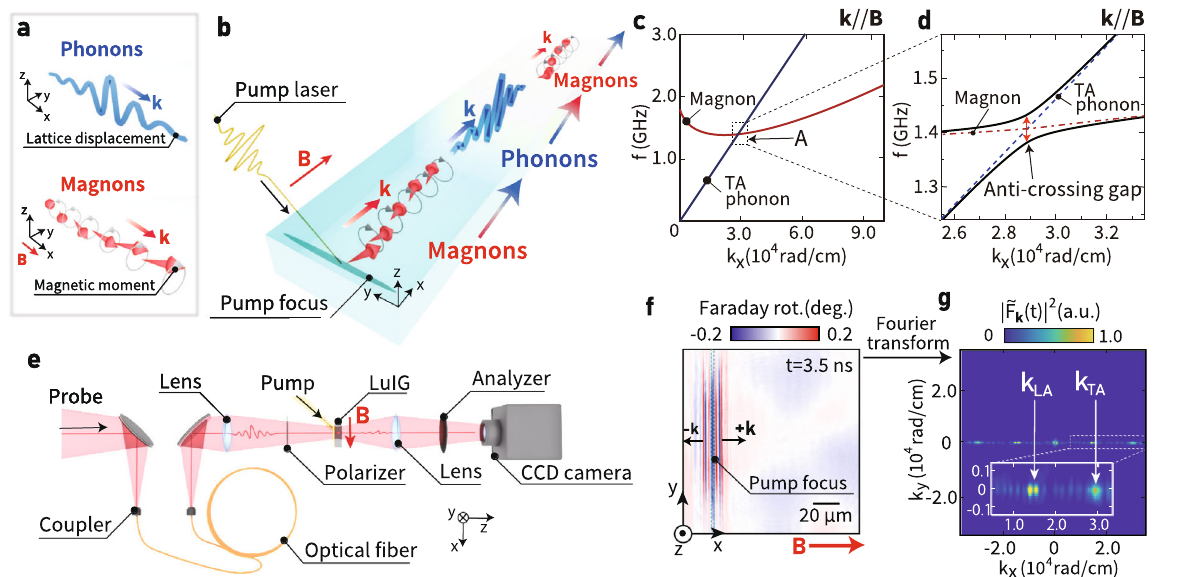
Fig. 1 Concept of coherent oscillation between phonons and magnons, and time-resolved magneto-optical microscopy. a A schematic illustration of phonons and magnons, b A schematic illustration of coherent oscillation between phonons and magnons. c The dispersion curves of phonon and magnon in lutetium iron garnet (LuIG). d A magni fi ed view around A in Fig. 1c. The black curves represent the dispersion relation of hybridized magnon-phonon polaron, while the red and blue dashed curves represents dispersion relation of pure magnons and transverse acoustic phonons, respectively. e Optical setup for the time-resolved magneto-optical microscopy with the extended delay time. The excited magnetization dynamics is detected via the polarization rotation angle of the probe laser pulse induced by the magneto-optical Faraday effect in the sample. The detection is performed by an charge-coupled device (CCD) camera. f Magneto-optical image observed 3.5 ns after the pump pulse irradiation under the external magnetic fi eld B = 11.5 mT parallel to the wavevector of the excited magnons. g , Wavenumber spectrum of the obtained magneto-optical images observed 3.5 ns after the excitation ( B = 11.5 mT). The inset shows a magni fi ed